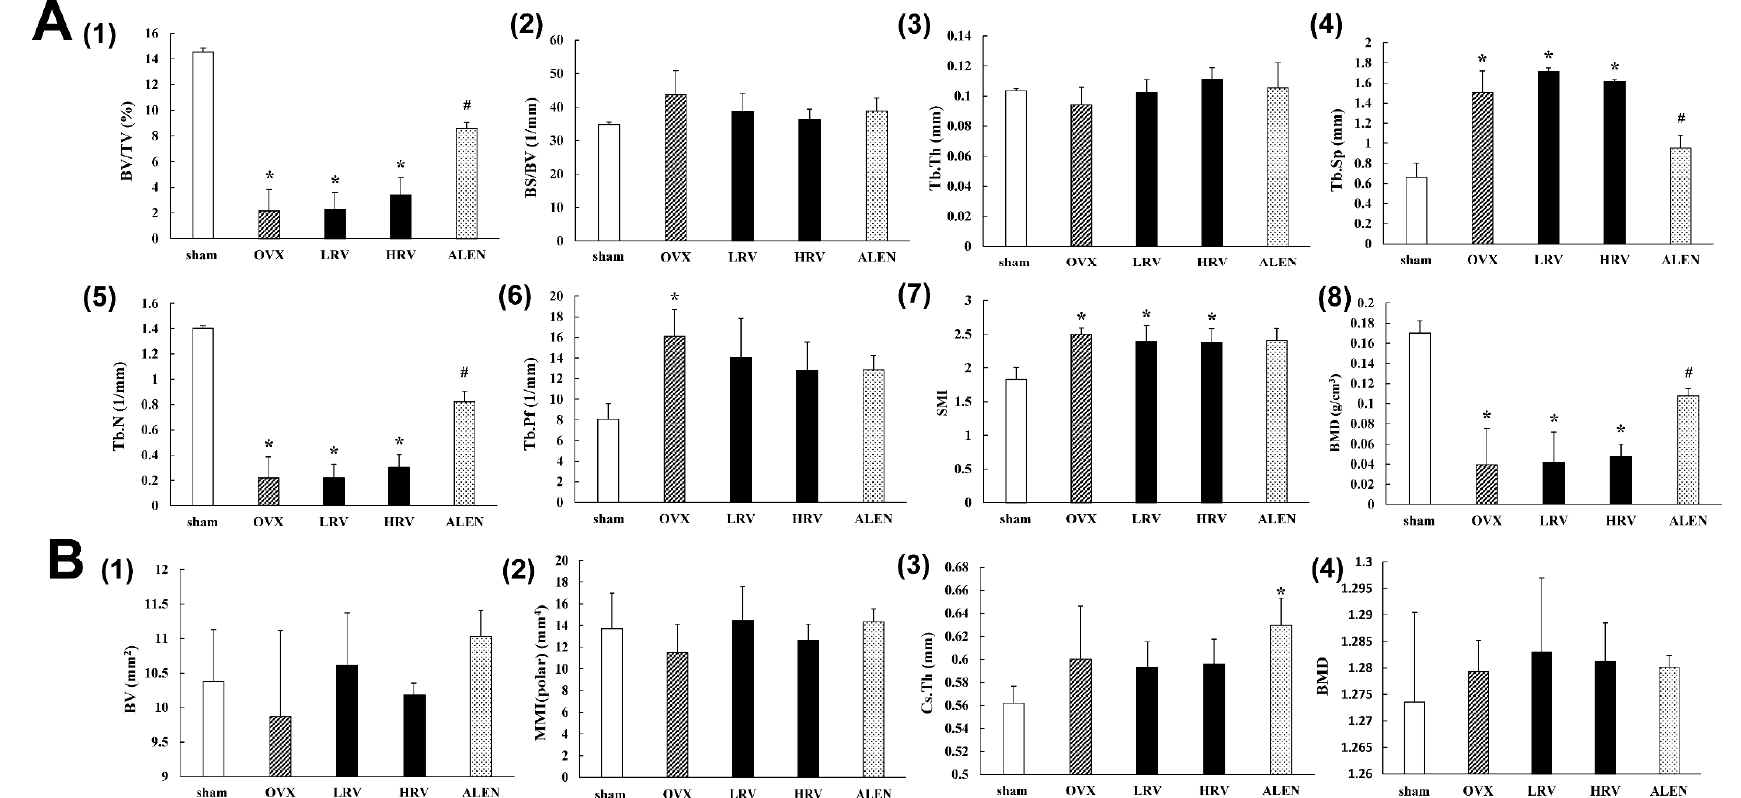
Figure 2. Monitoring of the trabecular bone ( A ) and cortical bone ( B ) parameters by the three-dimensional micro-CT analysis program. Trabecular bone parameters assessed ( A ): (A1) BV/TV, bone volume/tissue volume; (A2) BS/BV, bone surface/tissue volume; (A3) Tb.Th, trabecular thickness; (A4) Tb.Sp, trabecular separation; (A5) Tb.N, trabecular number; (A6) Tb.Pf, trabecular pattern factor; (A7) SMI, structure model index; (A8) BMD, bone mineral density. Cortical bone parameters assessed ( B ): (B1) BV, bone volume density; (B2) MMI, mean polar moment of inertia; (B3) Cs.Th, cross-section thickness; (B4) BMD, bone mineral density. sham, sham-operated control; OVX, ovariectomized rat without treatment; LRV, ovariectomized rat treated with low-dose RC vinegar; HRV, ovariectomized rat treated with high-dose RC vinegar; ALEN, ovariectomized rat treated with alendronate. * p < 0.05 compared to the sham, # p < 0.05 compared to the OVX group.